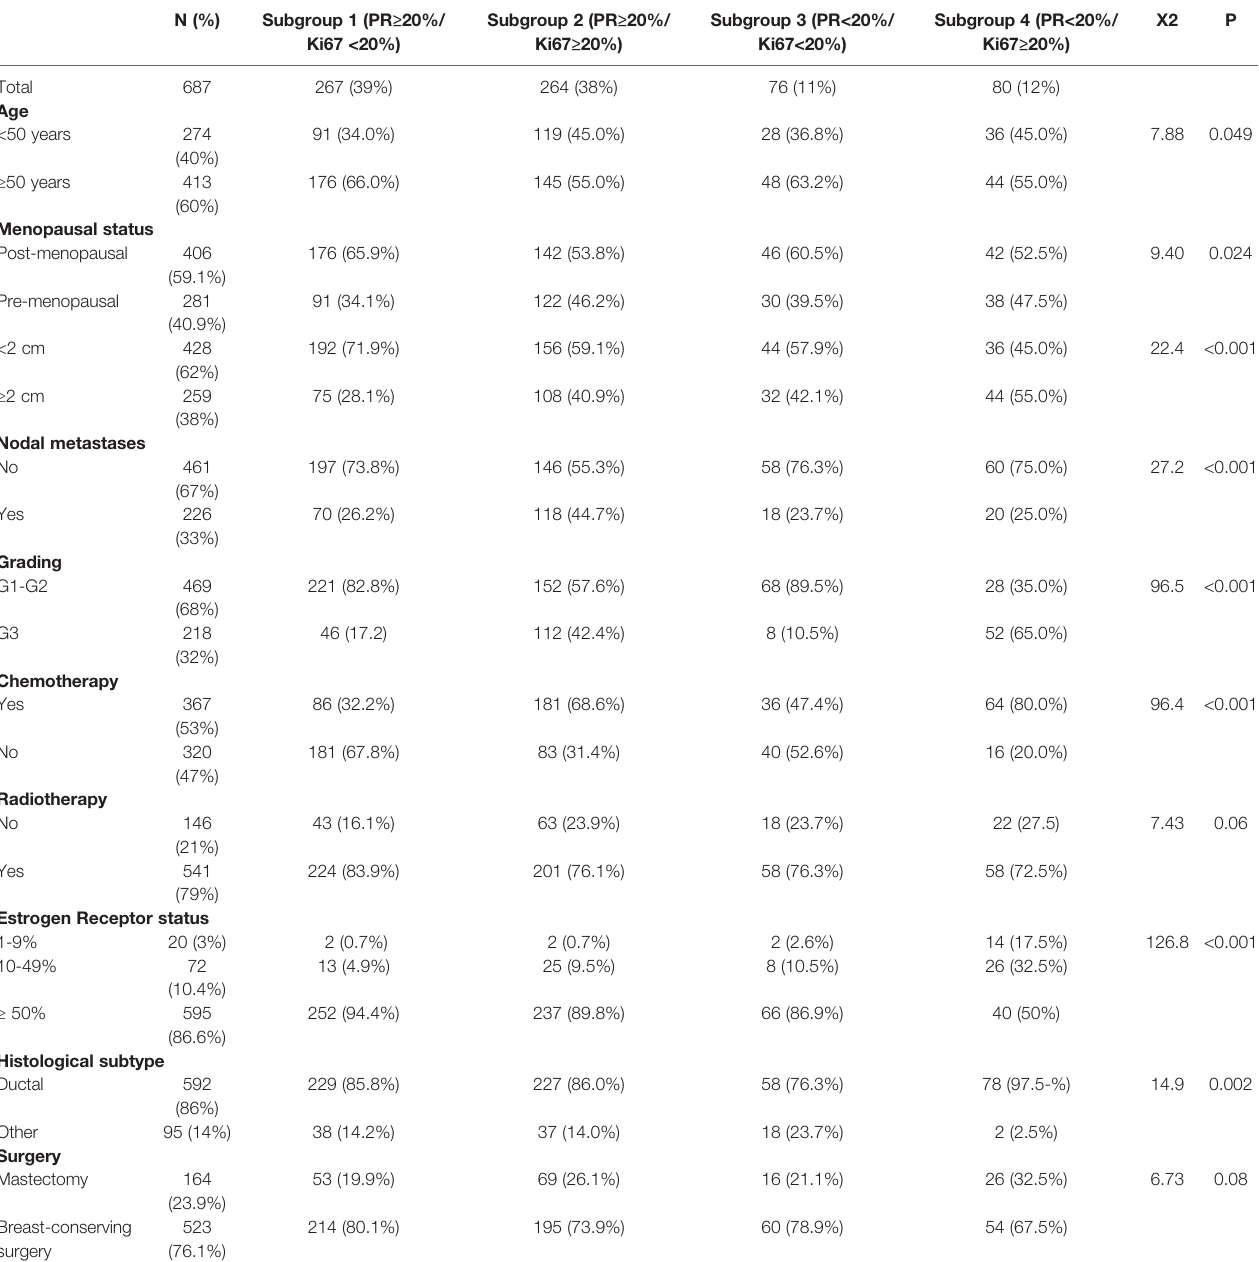
TABLE 1 | Clinicopathological characteristics of 687 patients with luminal-like HER2-negative. BC according to different PR and Ki67 expression levels